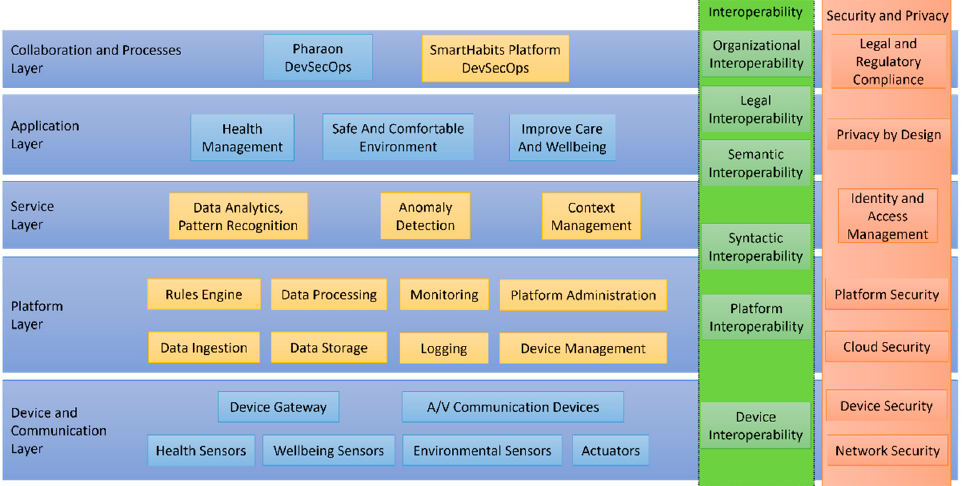
Figure 9. SmartHabits Platform mapped to Pharaon architecture.